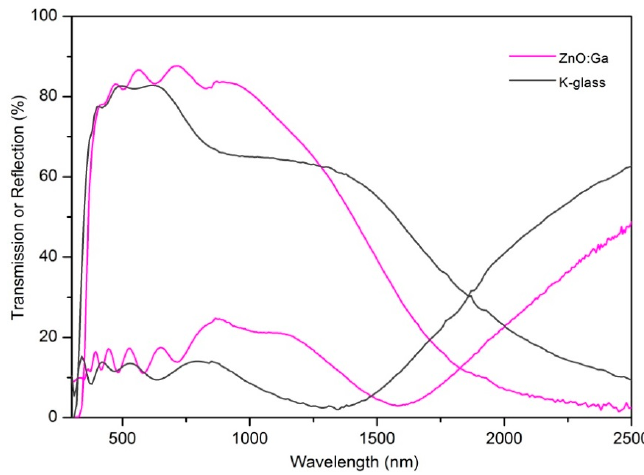
Figure 7. Optical transmission and reflection spectra of ZnO:Ga films grown by AACVD.